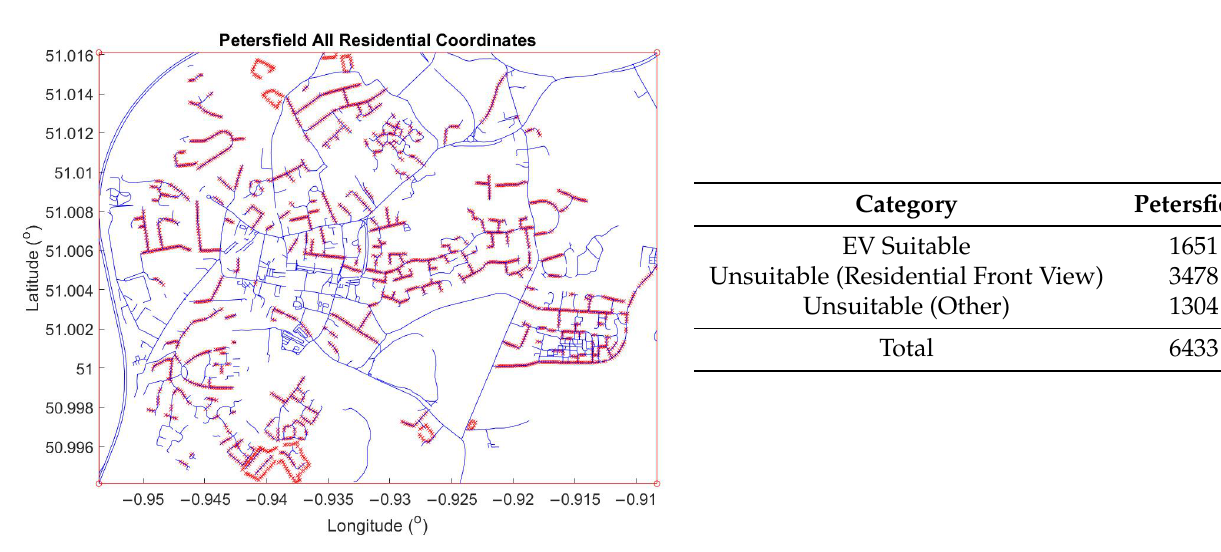
Figure 6. The locations of all downloaded images from the Petersfield test area ( Left ) and a breakdown of the image categories ( Right